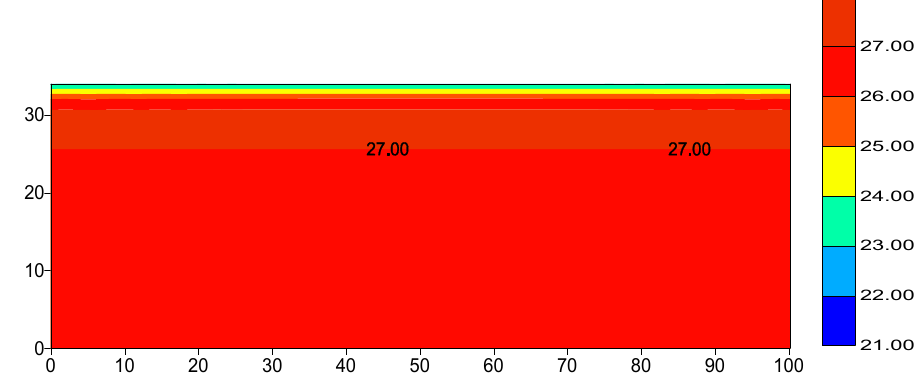
Figure 4. Foundation temperature distribution ( °C ).